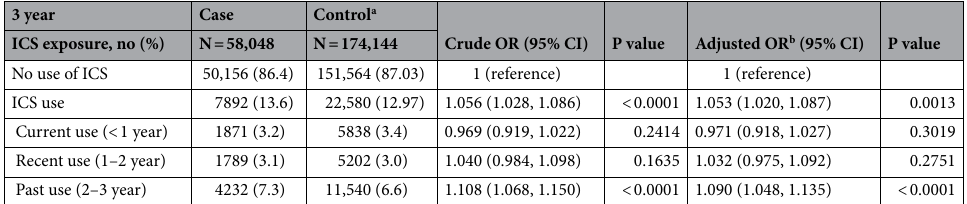
Table 2. Risk of osteoporosis with use of ICS compared with nonuse, stratified by exposure time. OR odds ratio. a Case and control matched by age group, gender, COPD severity, asthma, dyslipidemia, hypertension, diabetes mellitus, chronic kidney disease, chronic liver disease, and malignancy. b Adjusted for age group, gender, urbanization level, income, COPD severity, comorbidity, the oral steroids use and co-medication.